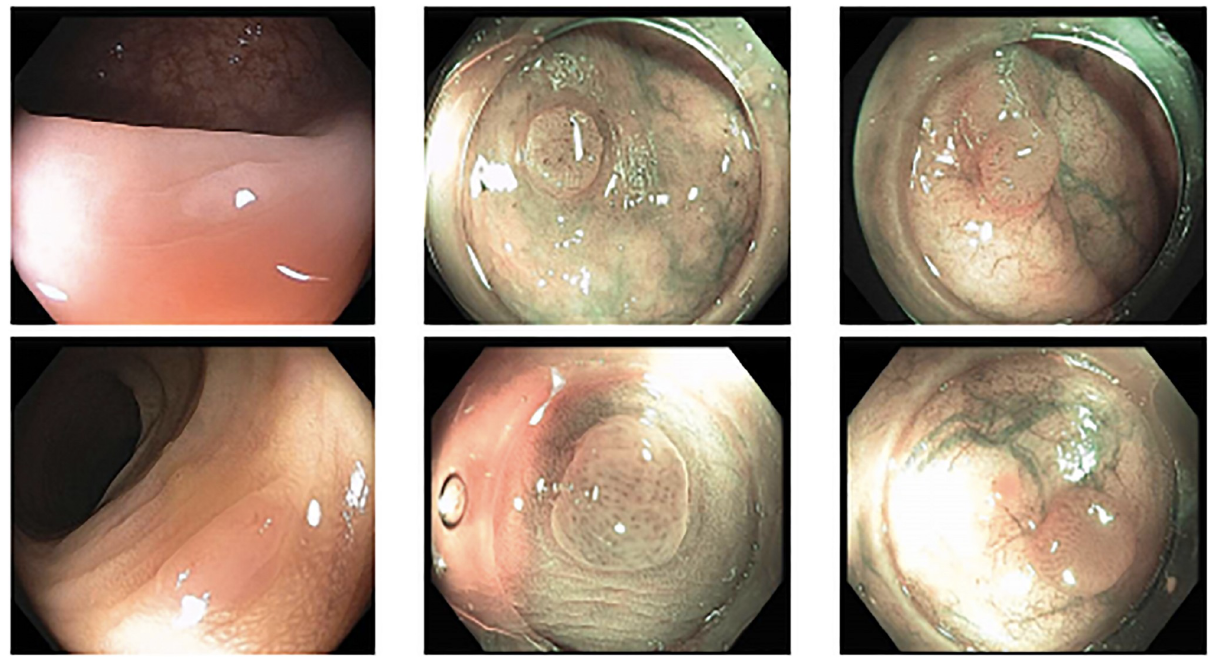
Fig 1. Example of polyps from different class with subtle difference: (a) Upper: Three examples of Adenomatous polyps. (b) Lower: Three examples of Hyperplastic polyps. They are visually very similar although from different categories.